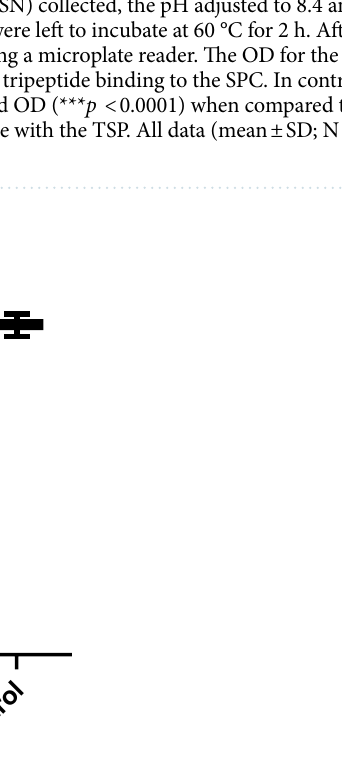
Figure 10. Immobilised Teic does not demonstrate biocidal activity against S. aureus . Aliquots (50 mg) of TSP and a silica particle control (SPC; 50 mg) were exposed to a 10 5 CFU/mL suspension of S. aureus and incubated for 24 h at 37 °C. A bacterial culture alone and a culture containing free Teic (600 µg/ml) served as controls. As anticipated, cultures treated with free Teic led to complete bacterial demise (*** p < 0.0001). In contrast, the TSP cultures exhibited similar bacterial numbers to SPC and bacterial controls. All data (mean ± SD; N = 9) represent pooled triplicate runs from 3 independent